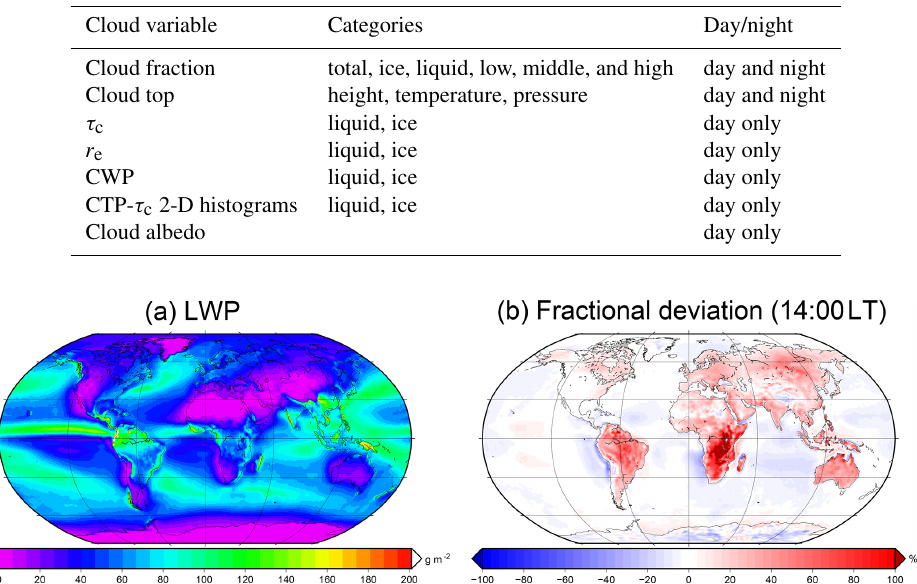
Figure 2. The total average LWP from EC-Earth based on available all time steps (a) , and the fractional deviation of the average LWP from sampling at 14:00LT compared to the day average